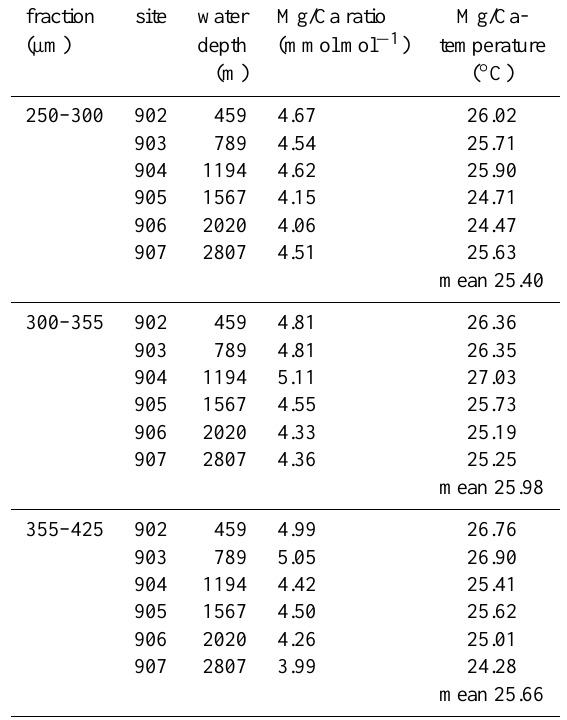
Table 3. Salinity and oxygen isotope composition of surface waters in the research area, measured and sampled in June 1992.